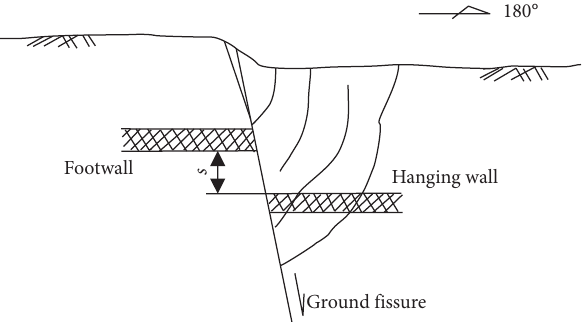
Figure 1: Movement of ground fissure.